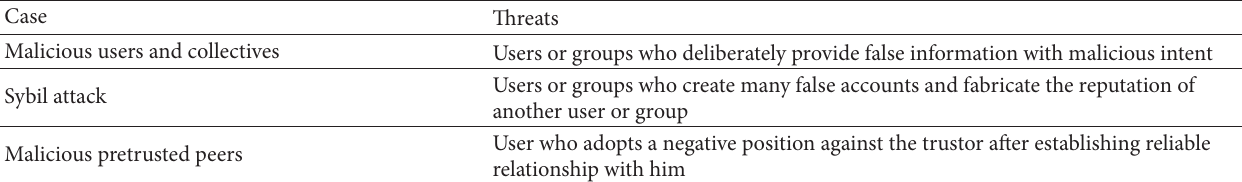
Table 1: Threats related to trust in